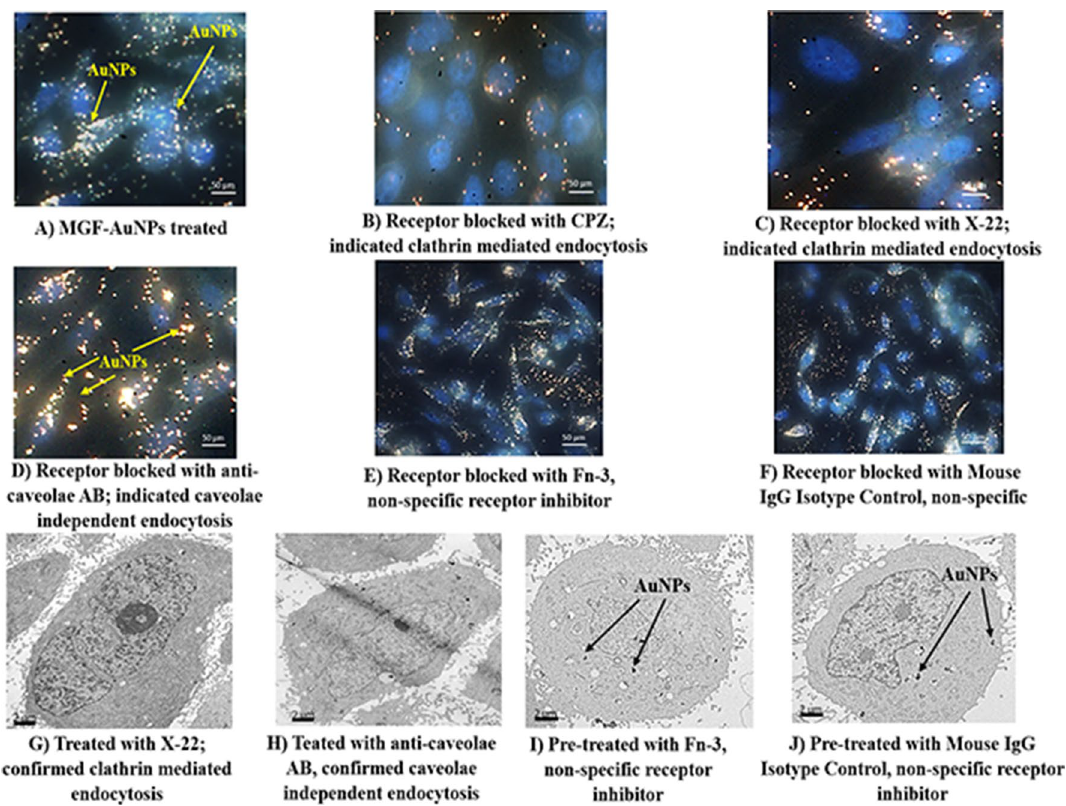
Figure 2. Clathrin mediated endocytosis of MGF-AuNPs ( A – F ): Dark field (CytoViva) microscopic images; ( G – J ): TEM Images showing PC-3 cells pretreated with Chlorpromazine, anticlarthrin AB, anti-caveolae AB, anti-fibronectin AB, and mouse IgG Isotype control AB, followed by treatment with MGF-AuNPs (41 µM). Images infer clathrin dependent and caveolae independent pathways for the endocytosis of MGF-AuNPs in PC-3